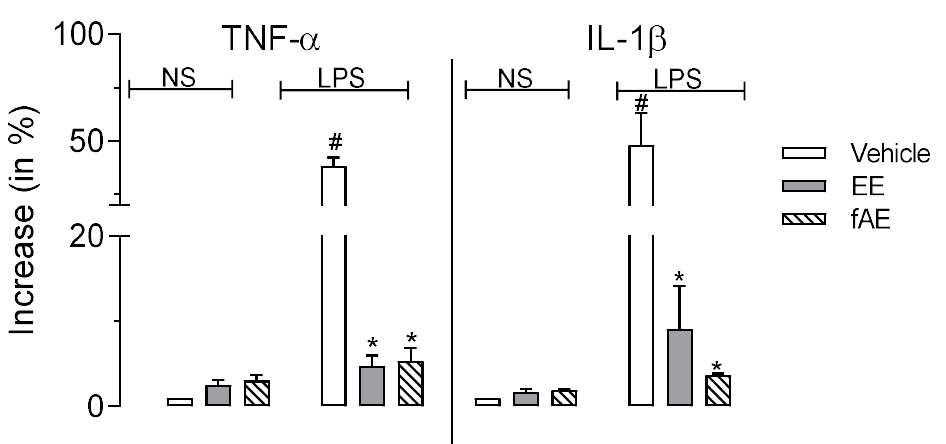
Figure 8. Effects of EE and fEA from T. granulosa in TNF- α , IL-1 β gene expression. Freshly isolated human polymorphonuclear cells (PMNs) were preincubated with EE or fEA (30 µ g/mL) in non-activated (NS) or activated with lipopolysaccharide (LPS, 1 µ g/mL). Gene expression for each cytokine was evaluated through RT-PCR. Results show fold increases in gene expression. The statistical significance was calculated using ANOVA followed by the post-test of Newman–Keuls. * p < 0.05 when comparing cells that were pre-treated with EE or fEA (30 µg/mL) to cells that received only LPS. # p < 0.05 when comparing LPS-activated cells with non-activated cells (NS) receiving vehicle.